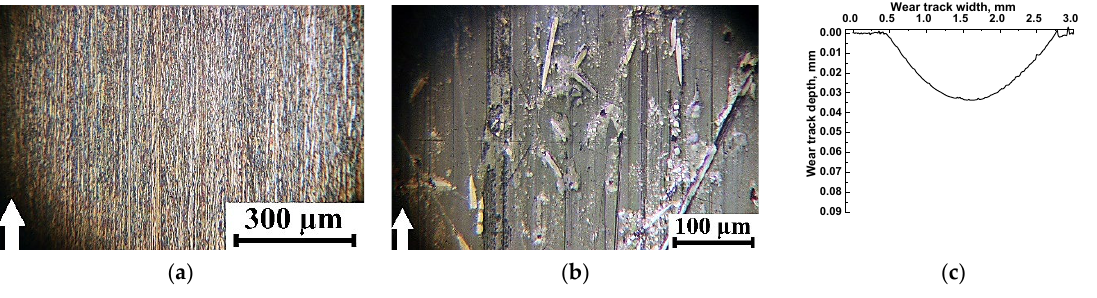
Figure 17. Micrographs of the steel counterpart surface ( a ), wear track ( b ) and its profile ( c ) after the tribological tests of the PEI/10CCF/1CNT nanocomposite. Linear tribological contact. P = 180 N, V = 0.5 m/s.